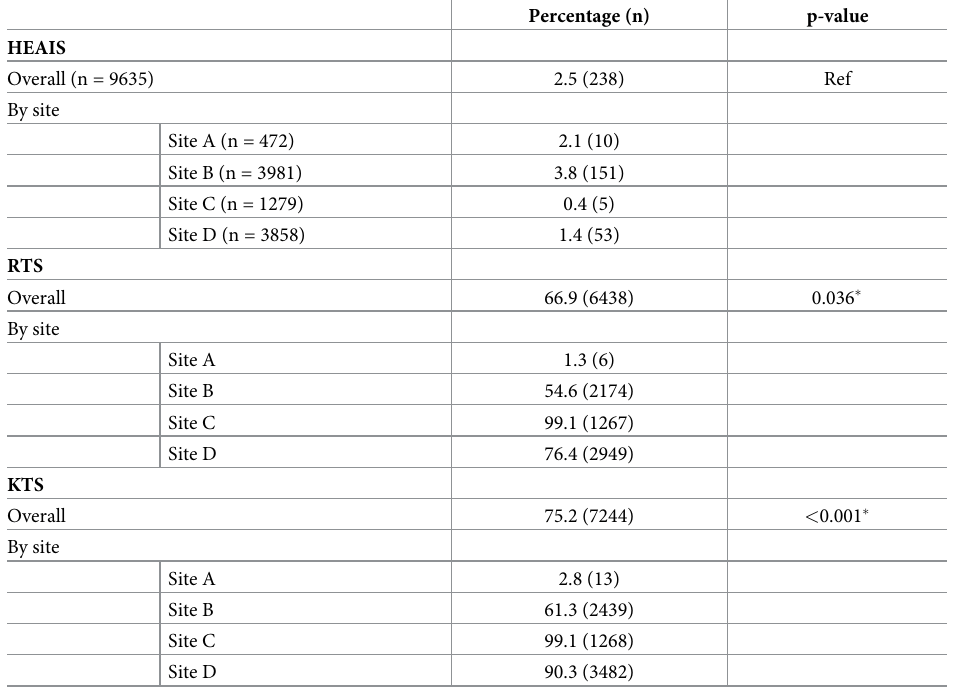
Table 2. Injury scoring data missingness by site (n = 9635).